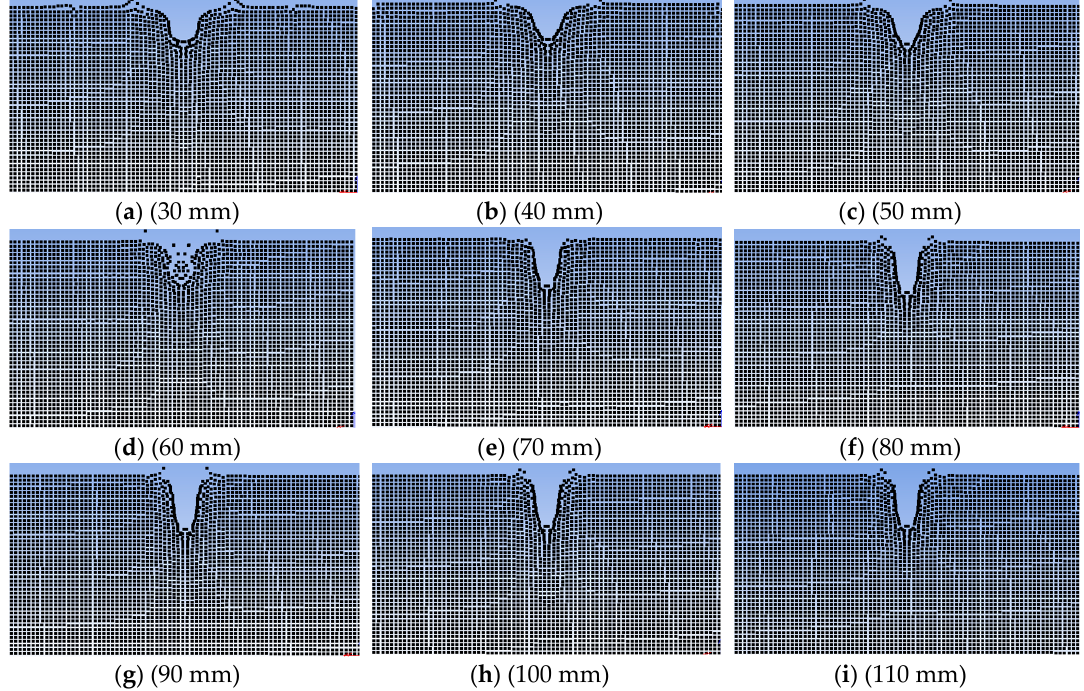
Figure 11. ( a – i ) Simulation calculation results for nine high explosion conditions.